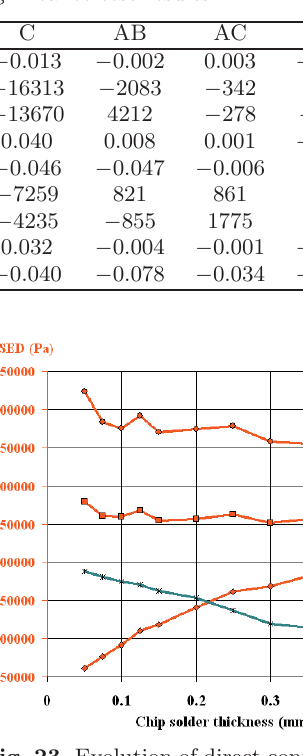
Fig. 22. Evolution of bump solders ISED and module thermal impedance with bump size and material.